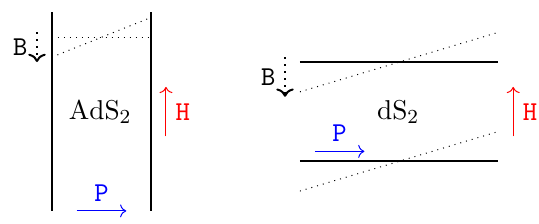
Figure 1 . Penrose diagrams for AdS 2 (left) and dS 2